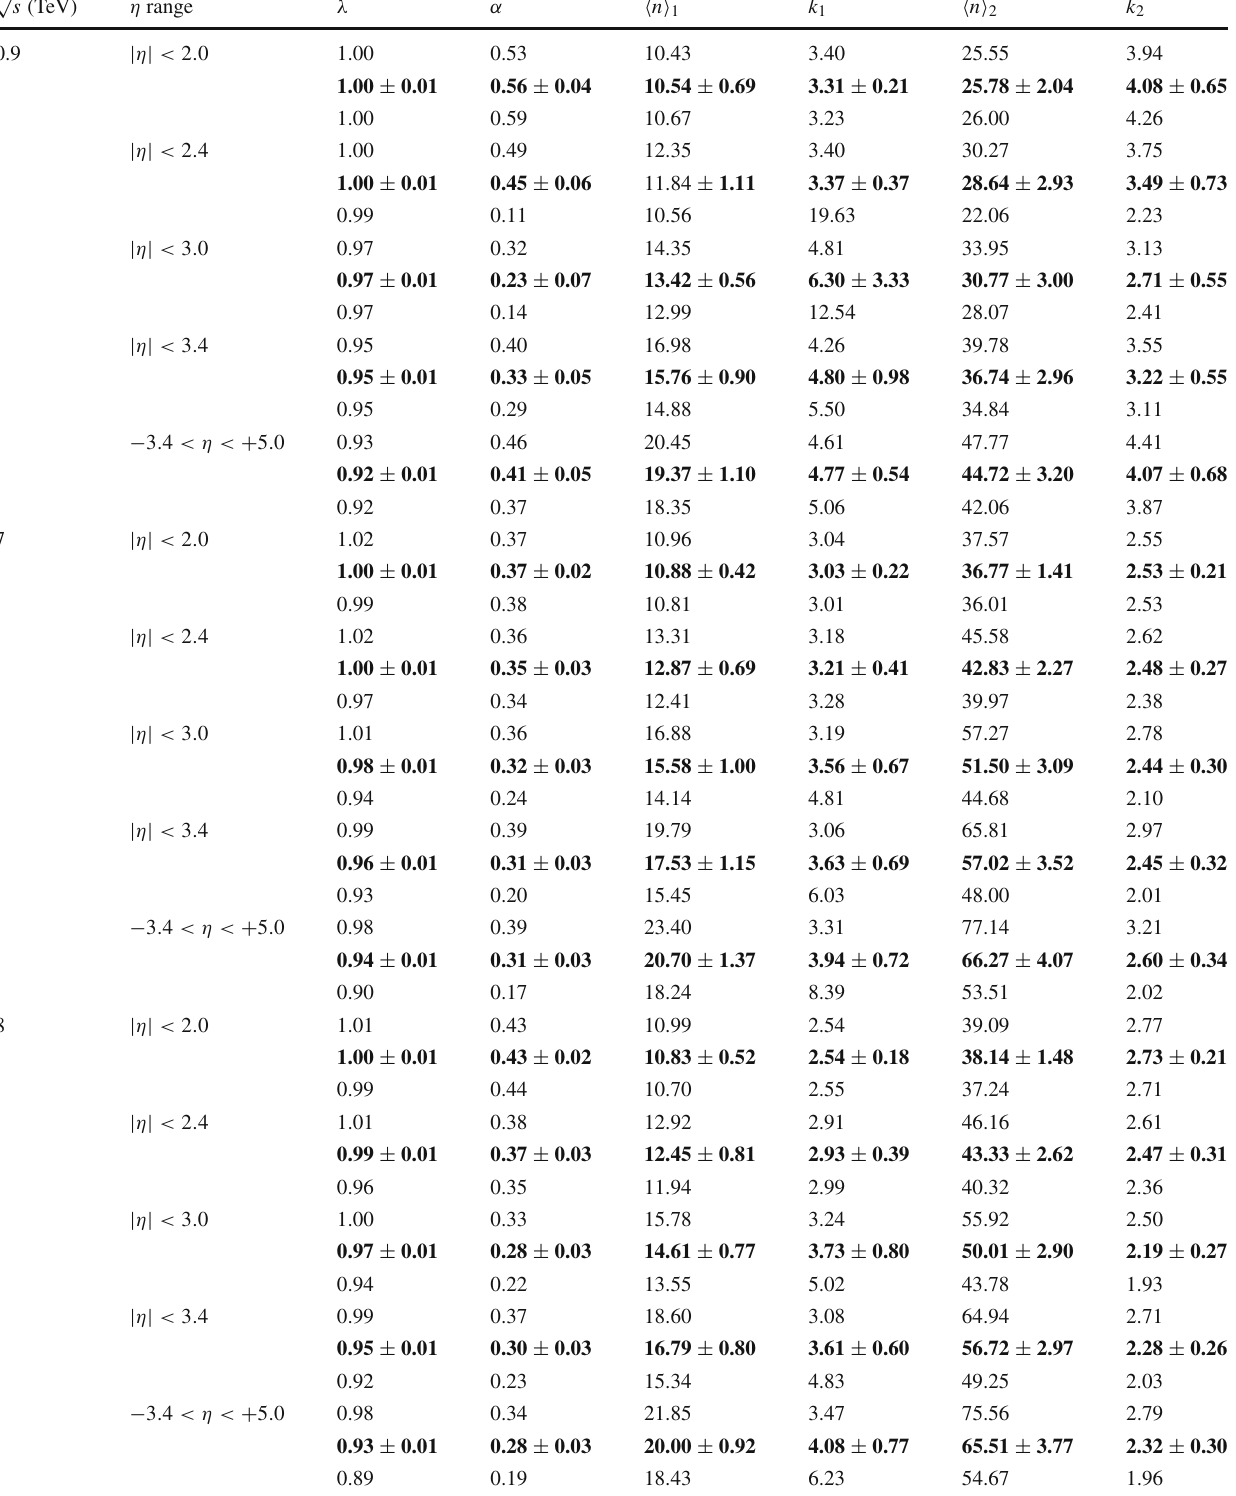
Table 6 Double NBD fit parameters for multiplicity distributions, INEL > 0 events. The central values of the parameters are printed in bold with their relative uncertainty, while the top row shows the upper bound fit parameters, and the bottom row the lower bound ones